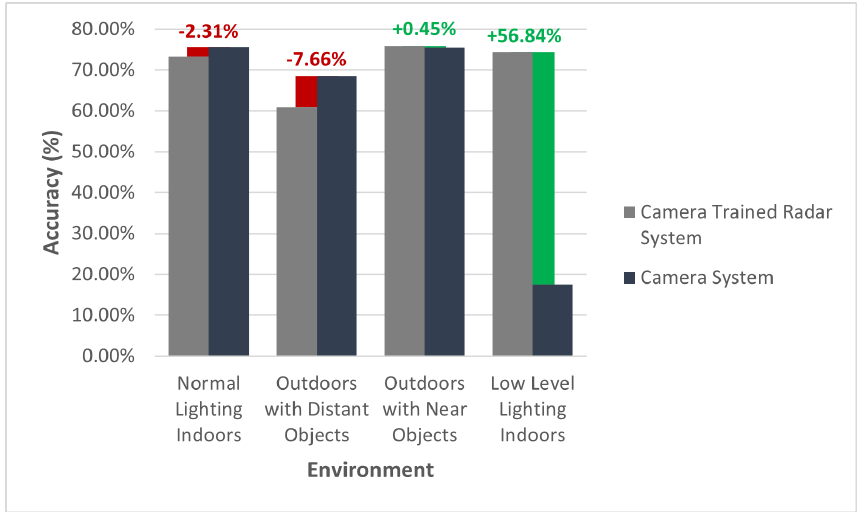
Figure 8. Camera-trained radar system accuracy in contrast to a trained standalone camera